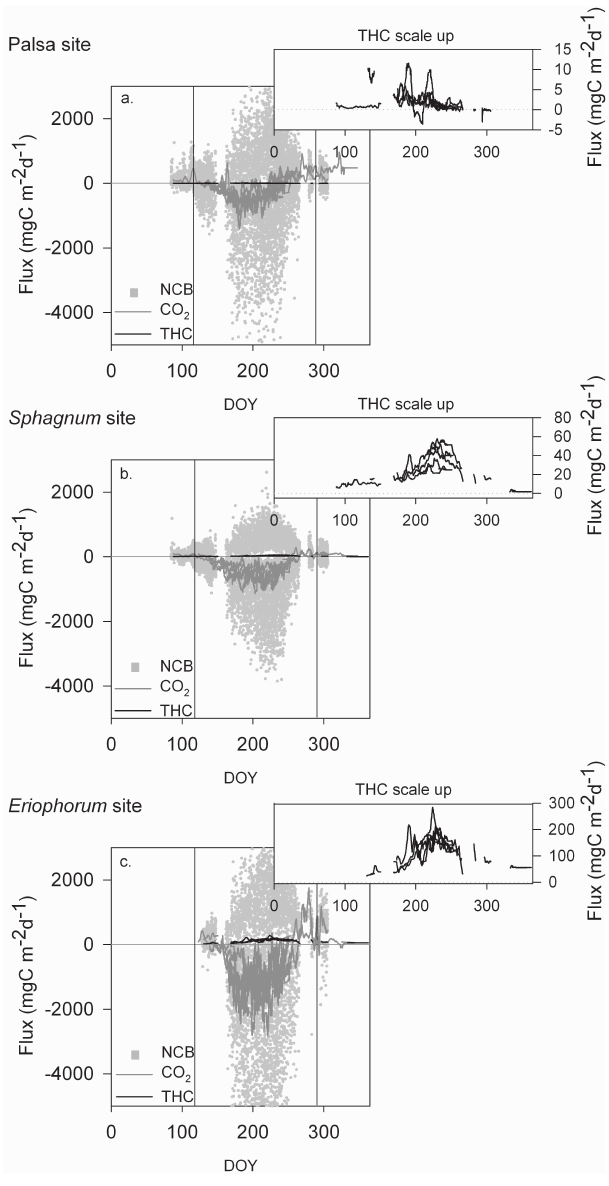
Fig. 3. Three day running mean of CO 2 and THC presented as lines, and NCB (sum of CO 2 and THC) estimates are presented as indi- vidual data points. Because the THC component measured in gram C is very small compared to CO 2 , the seasonal distribution of the NCB measurement points can be considered to also show the large scale seasonal variation for CO 2 . Positive numbers represent ad- dition to the atmosphere and negative numbers represent loss from the atmosphere. The time period between vertical lines at DOY 119 and DOY 289 indicate the limit of the green season. DOY on the x axes stands for day of year. All fluxes in mgCm − 2 d − 1